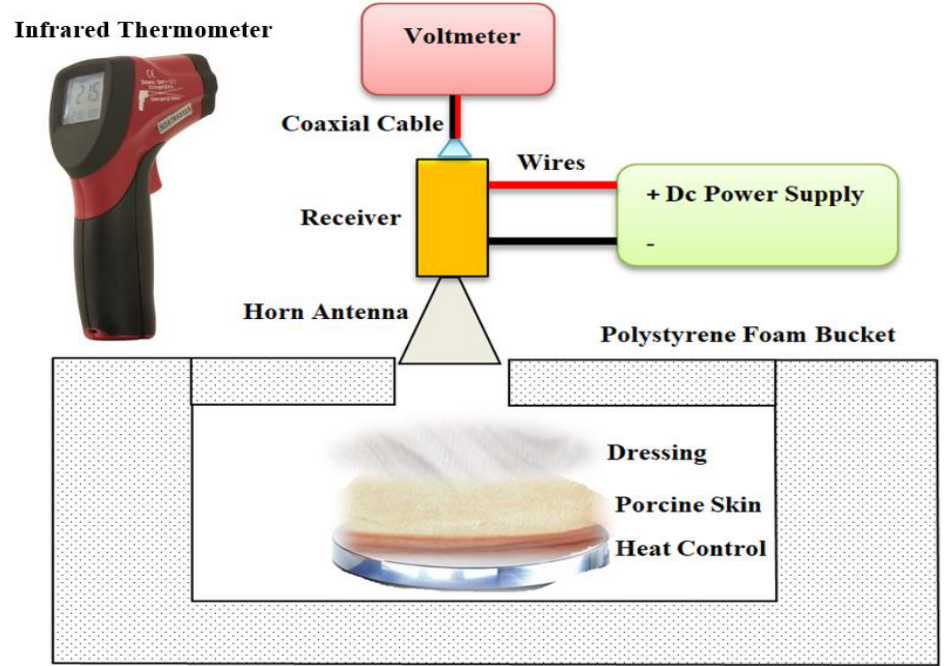
Figure 3. Experimental setup for the emissivity measurements of the porcine skin samples. A digital voltmeter is used to measure the output voltage level of the samples and a thermocouple and an infrared thermometer are used to measure the thermodynamic temperature of the samples.